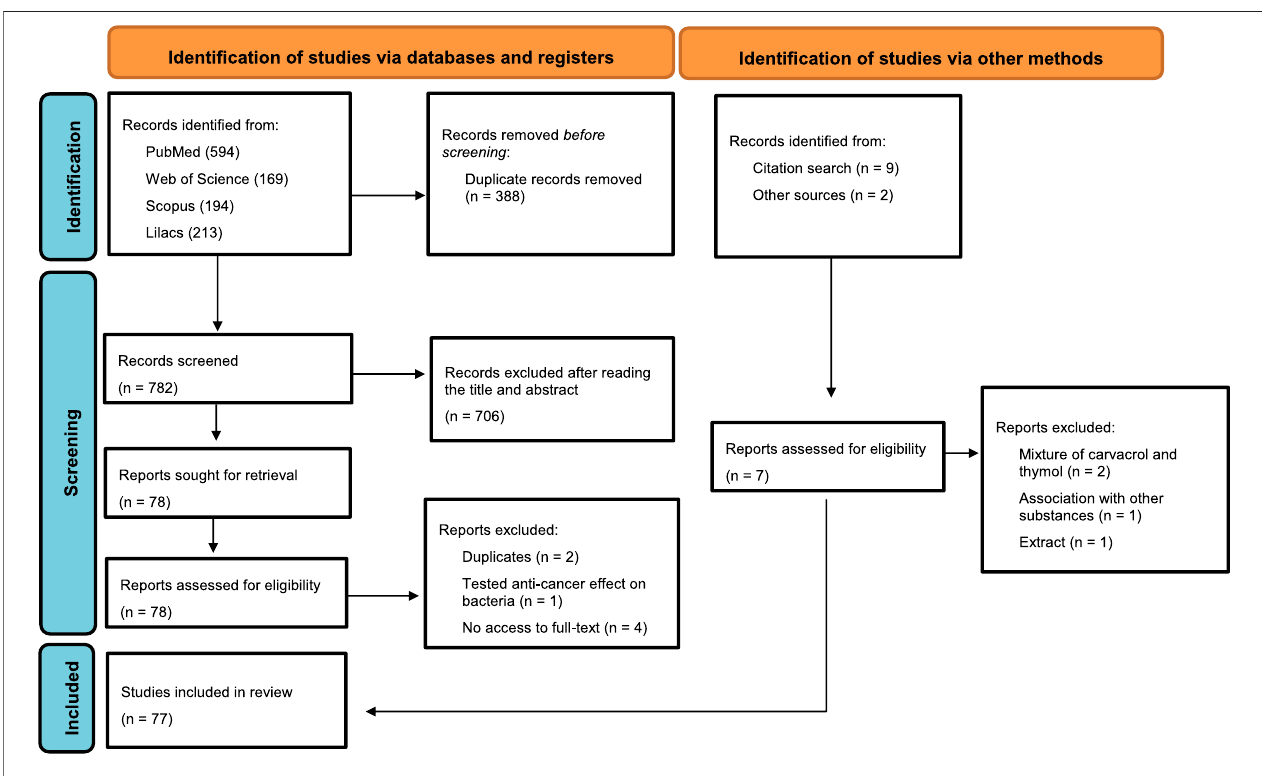
FIGURE 1 | Flowchart of included